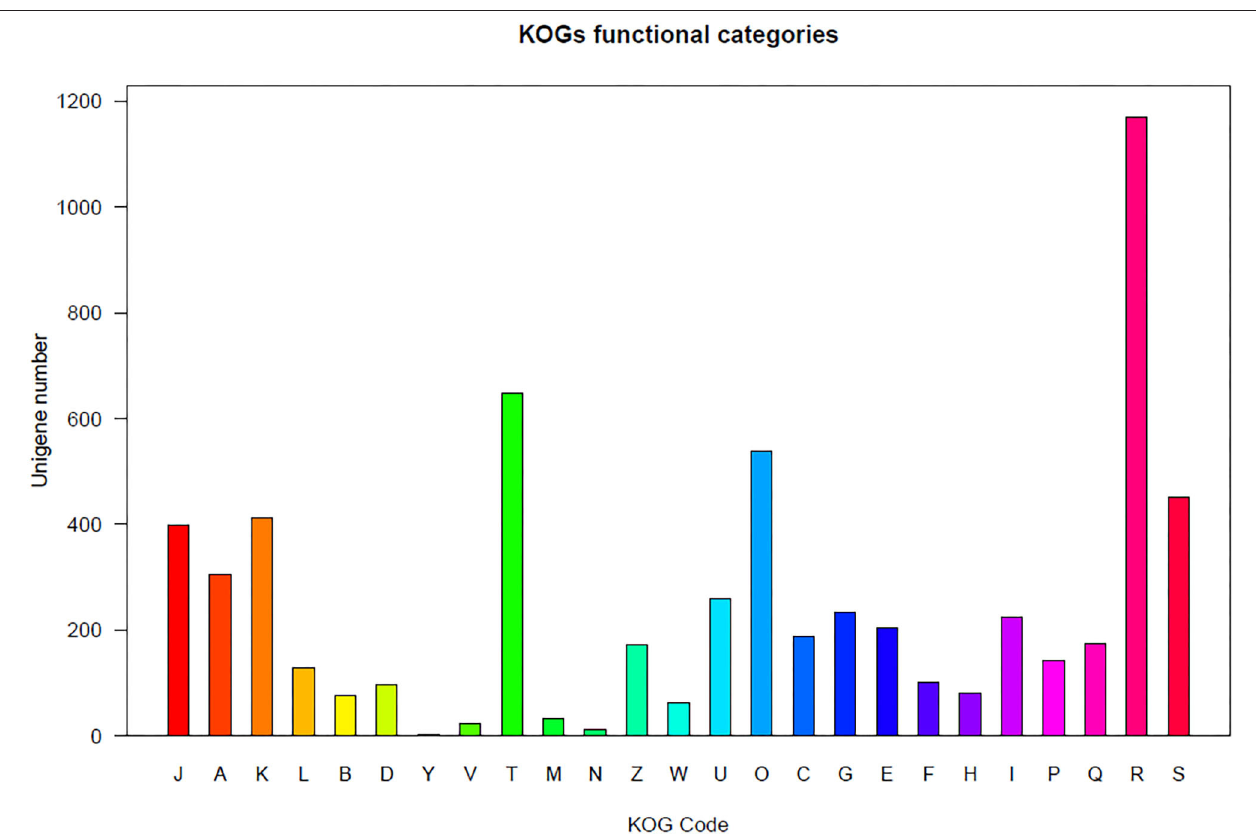
FIGURE 1 | Unigene-function clusterification by KOG. INFORMATION STORAGE AND PROCESSING [J] Translation, ribosomal structure, and biogenesis; [A] RNA processing and modification; [K] Transcription; [L] Replication, recombination, and repair; [B] Chromatin structure and dynamics. CELLULAR PROCESSES AND SIGNALING: [D] Cell cycle control, cell division, chromosome partitioning; [Y] Nuclear structure; [V] Defense mechanisms; [T] Signal transduction mechanisms; [M] Cell wall/membrane/envelope biogenesis; [N] Cell motility; [Z] Cytoskeleton; [W] Extracellular structures; [U] Intracellular trafficking, secretion, and vesicular transport; [O] Posttranslational modification, protein turnover, chaperones. METABOLISM: [C] Energy production and conversion; [G] Carbohydrate transport and metabolism; [E] Amino acid transport and metabolism; [F] Nucleotide transport and metabolism; [H] Coenzyme transport and metabolism; [I] Lipid transport and metabolism; [P] Inorganic ion transport and metabolism; [Q] Secondary metabolites biosynthesis, transport and catabolism. POORLY CHARACTERIZED: [R] General function prediction only; [S] Function